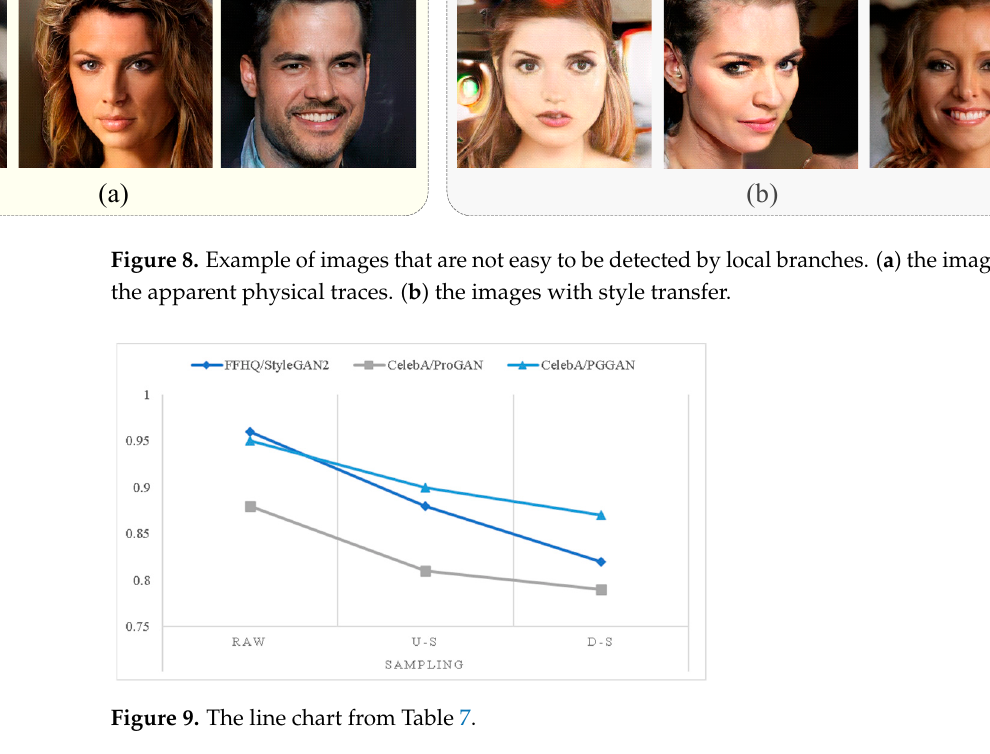
Figure 9. The line chart from Table 7.